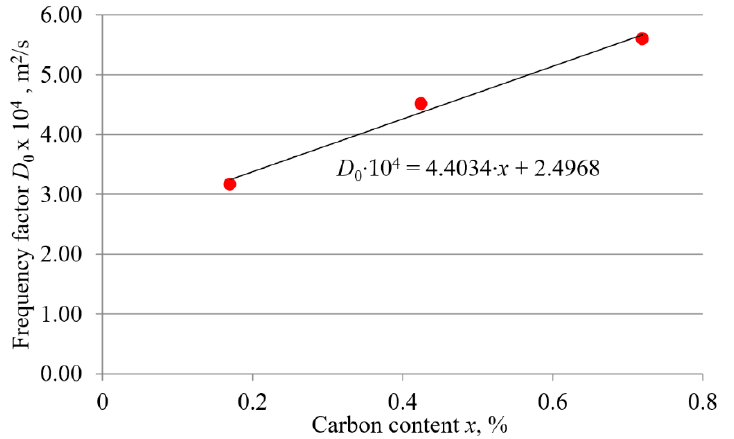
Figure 8. Relationship between the frequency factor and the carbon content of steel.